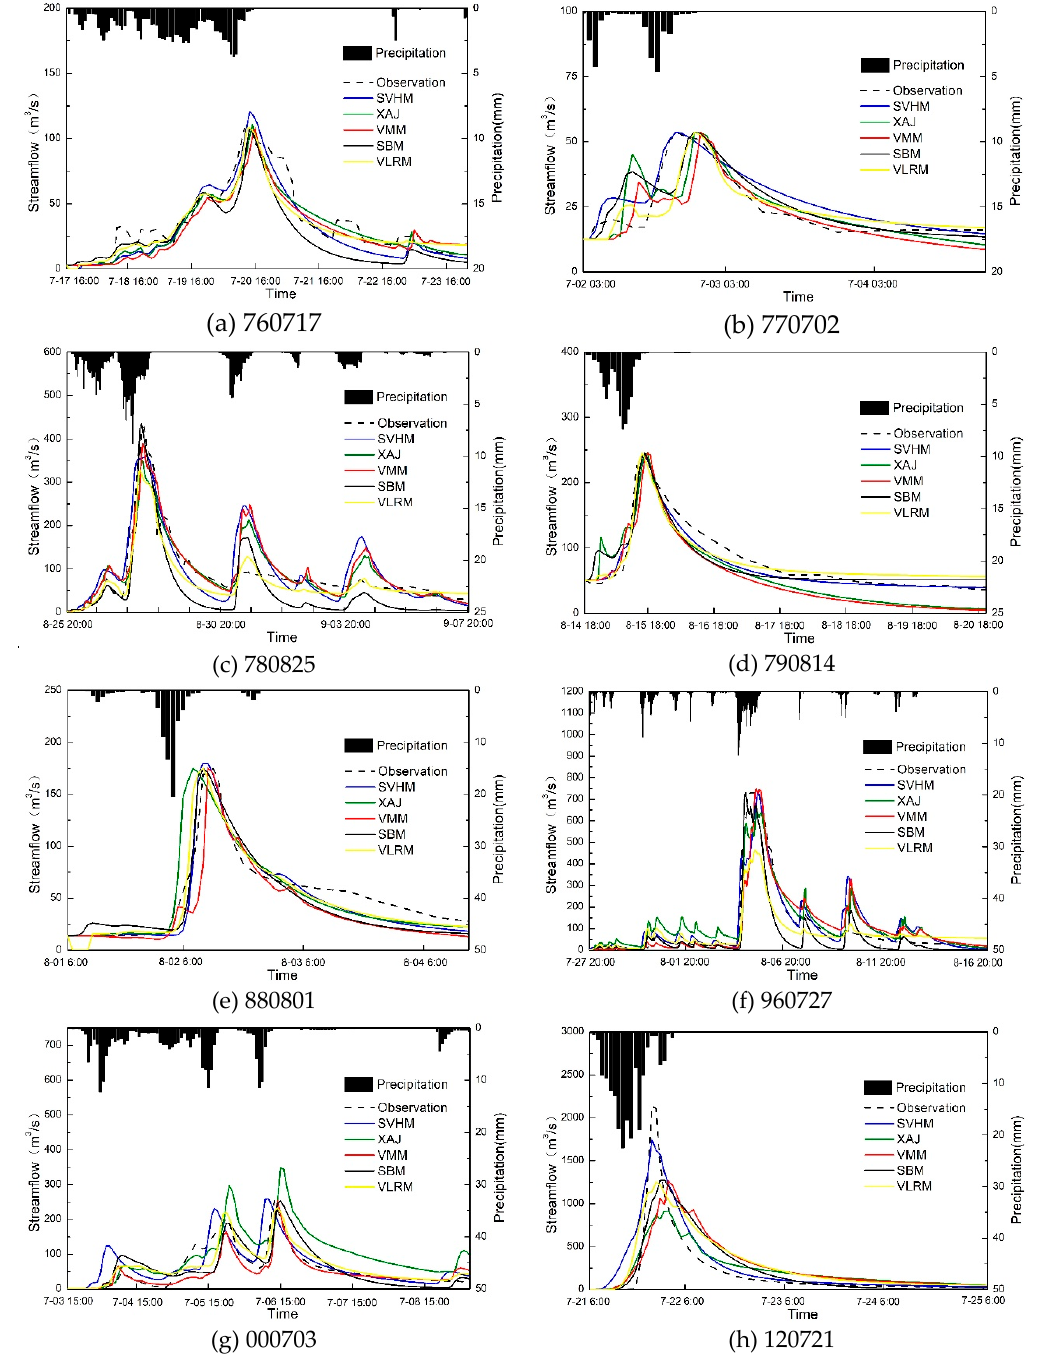
Figure 5. Comparisons of simulated and observed streamflow for some typical flood events in Zijingguan Basin (( a – e ) are calibration and ( f – h ) are validation). (Note: “Typical” here means that the floods are characterized by double or three flow peaks or single steep ‐ rising flood peak.